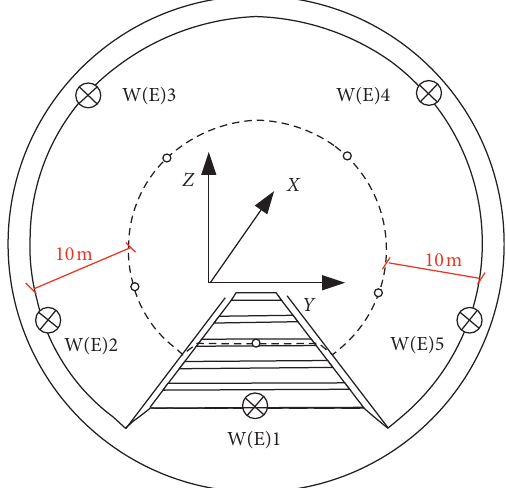
Figure 8: Schematic for measuring arrangements.